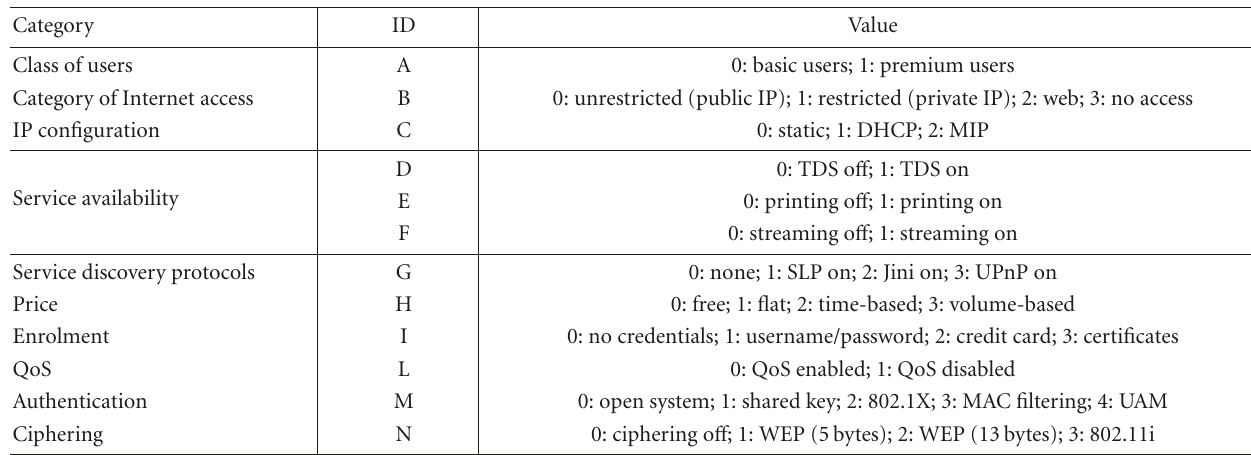
Table 2: Service-related information within the SSID IE.